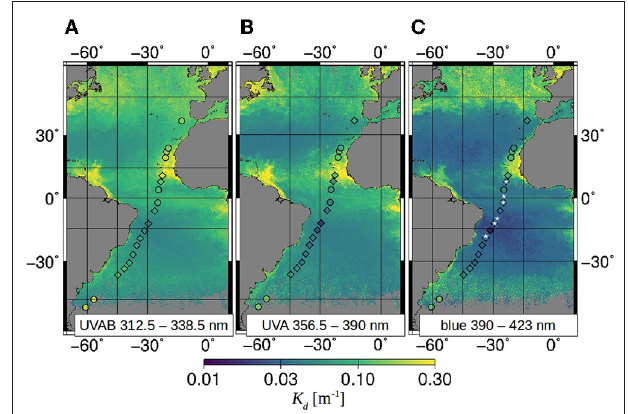
FIGURE 4 | VRS fit factors in the (A) UV, (B) short-blue, and (C) blue fit window in the Atlantic Ocean gridded at 0.083 ◦ as mean for 11 May to 9 June 2018.